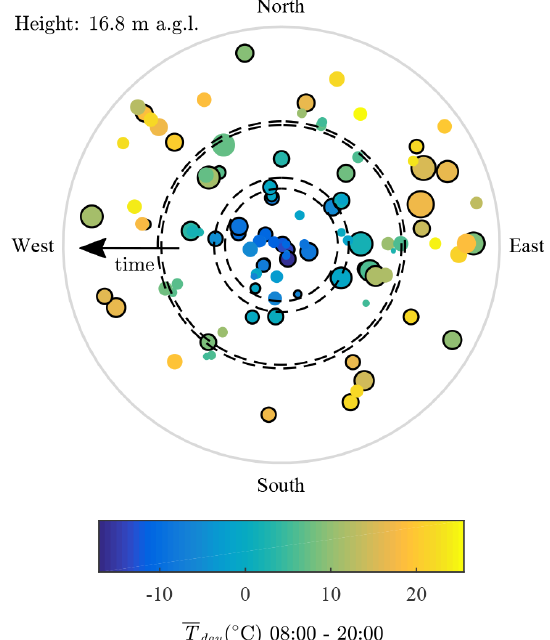
Figure A3. Wind rose illustrating multiple aerosol features, including relative average particle concentration (calculated from the SMEAR II DMPS and APS concentrations) and NPF events, as a function of air temperature, wind direction and time at 16.8m above ground level on the mast.